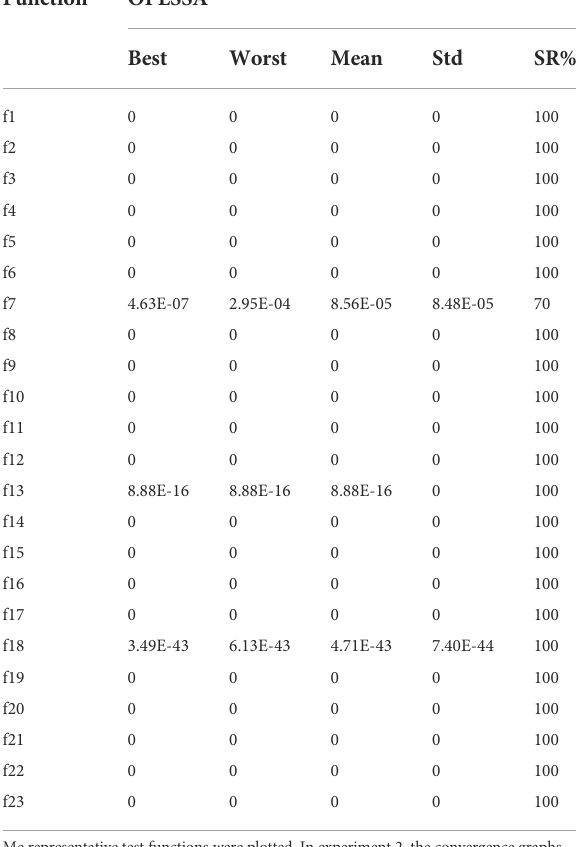
TABLE 7 Results obtained by OPLSSA on 10000-dimensional functions. Function